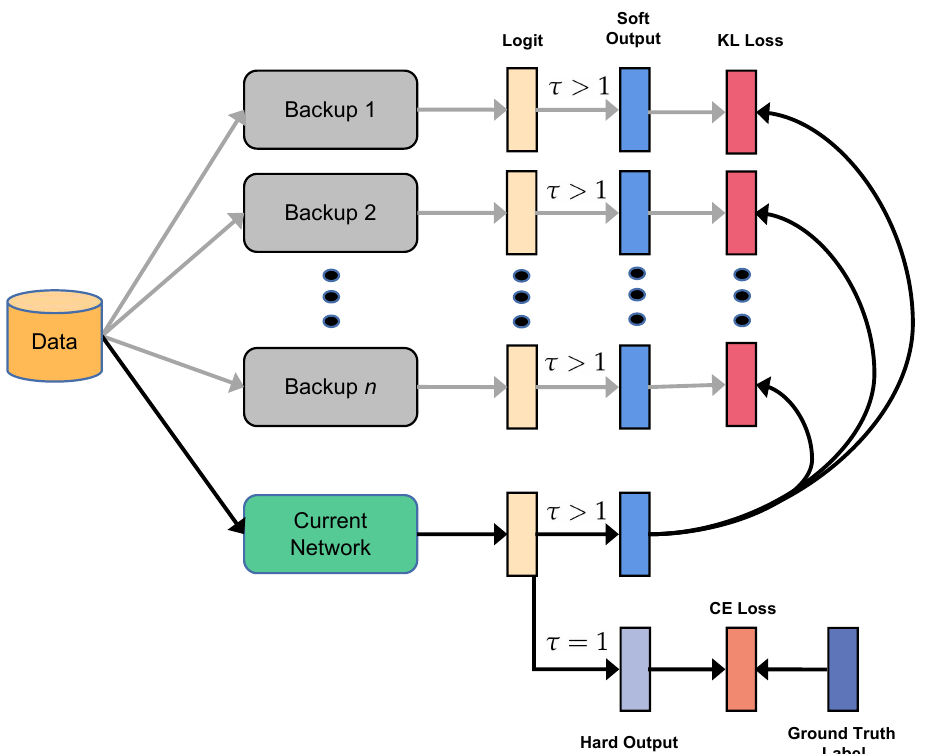
Figure 3. The framework of MrKD-plain without Fully Connected Network (FCN) ensemble and Knowledge Adjustment